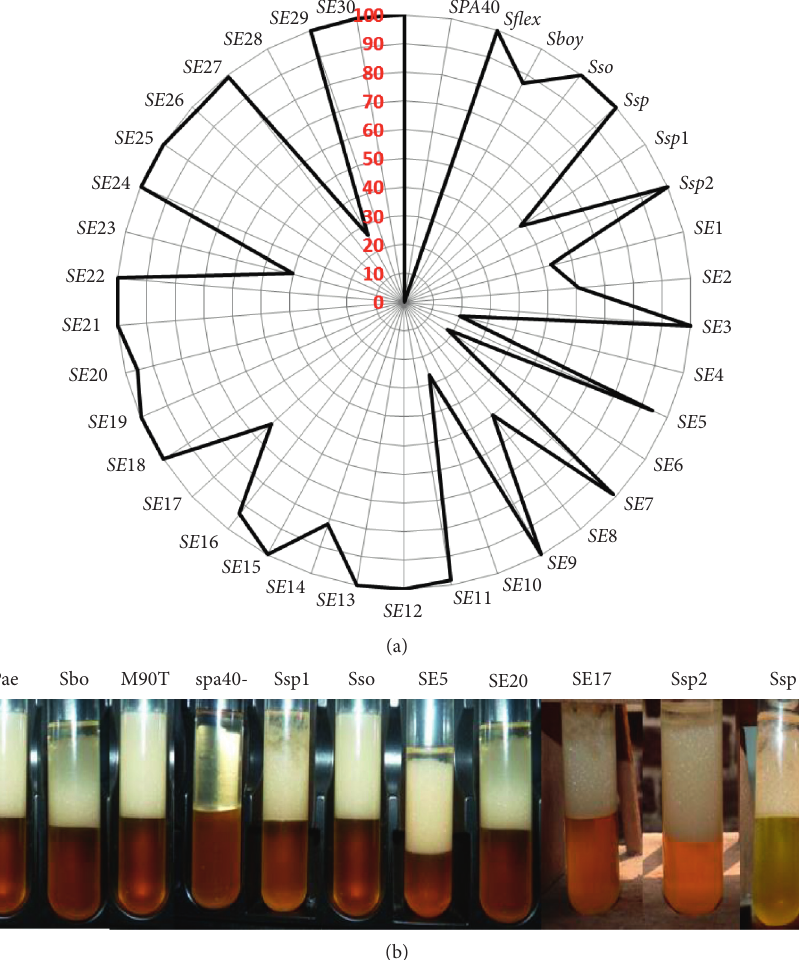
Figure 1: (a) Emulsification index percentage of all Shigella strains used in this study after 24 hours. Pae: P. aeruginosa used as positive control; M90T: Shigella flexneri 5a strain M90T; spa40 -: S. flexneri spa40 mutant; Sbo: S. boydii ; Sso : S. sonnei ; Ssp, Ssp1, Ssp2: Shigella sp. from clinical strains; SE1 to SE30: Shigella sp. from environmental strains. (b) Emulsification index appearance of some Shigella